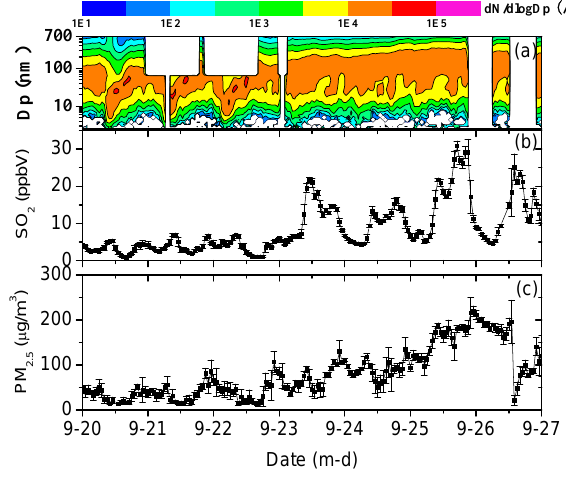
Fig. 9. Temporal variations of (a) particle size distribution, (b) SO 2 mixing ratio, and (c) PM 2.5 mass concentration from 20– 27 September 2011. Empty space denotes lack of measurements.